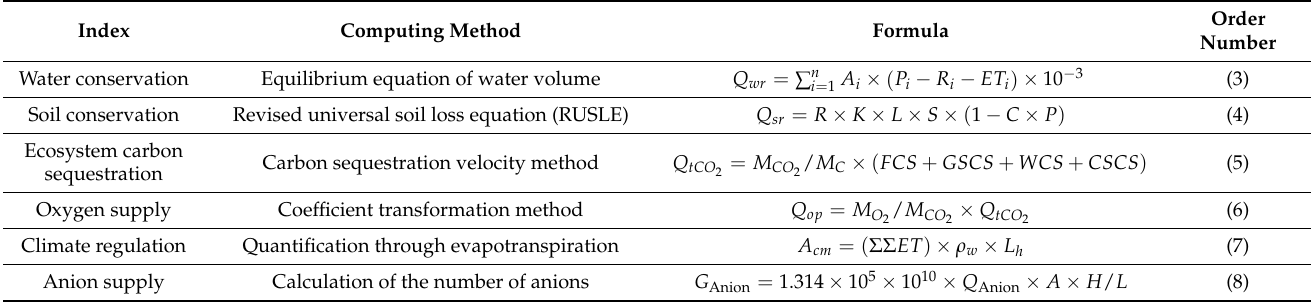
Table 1. Accounting method of ecosystem regulation services.